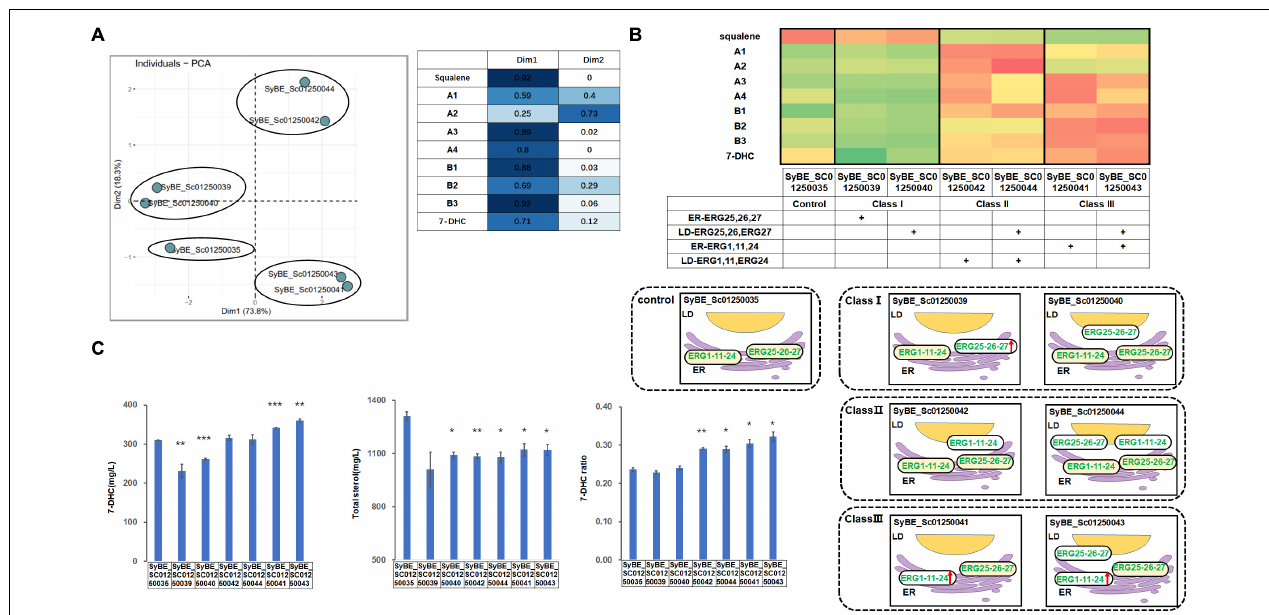
FIGURE 4 | Compartmentalized reconstitution of upstream post-squalene enzymes. (A) PCA analysis of sterol intermediates of the strains under compartmentalized reconstitution of upstream ERG enzymes (before B1). Different classes of strains are circled by ellipses. The table shows the composition of the two principal components in the PCA experiment (Dim1 and Dim2). (B) The post-squalene pathway metabolic flux heat map. The accumulation levels of post-squalene intermediates were normalized according to Y = (X – µ )/ σ , where Y represents the normalized value, X represents the original value, µ represents the mean value, and σ represents the standard deviation. The larger Y is presented by the color which is close to red, while the smaller one is close to green. The locations of engineered ERG proteins in the constructed strains are presented below the heat map. Backgrounds of the enzymes without modification are yellow. The up arrows represent protein overexpression. (C) 7-DHC productions, total sterols, and 7-DHC ratios of the constructed strains. All data were from at least triplicate experiments. T -test was conducted between the corresponding strain and the control strain SyBE_Sc0125XJ06. Significance levels of t -test: * P < 0.05, ** P < 0.01, *** P <